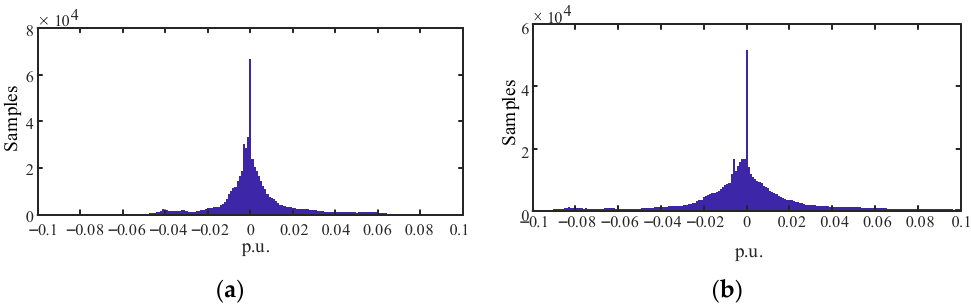
θ with +5% FDIAs). ( a ) 5